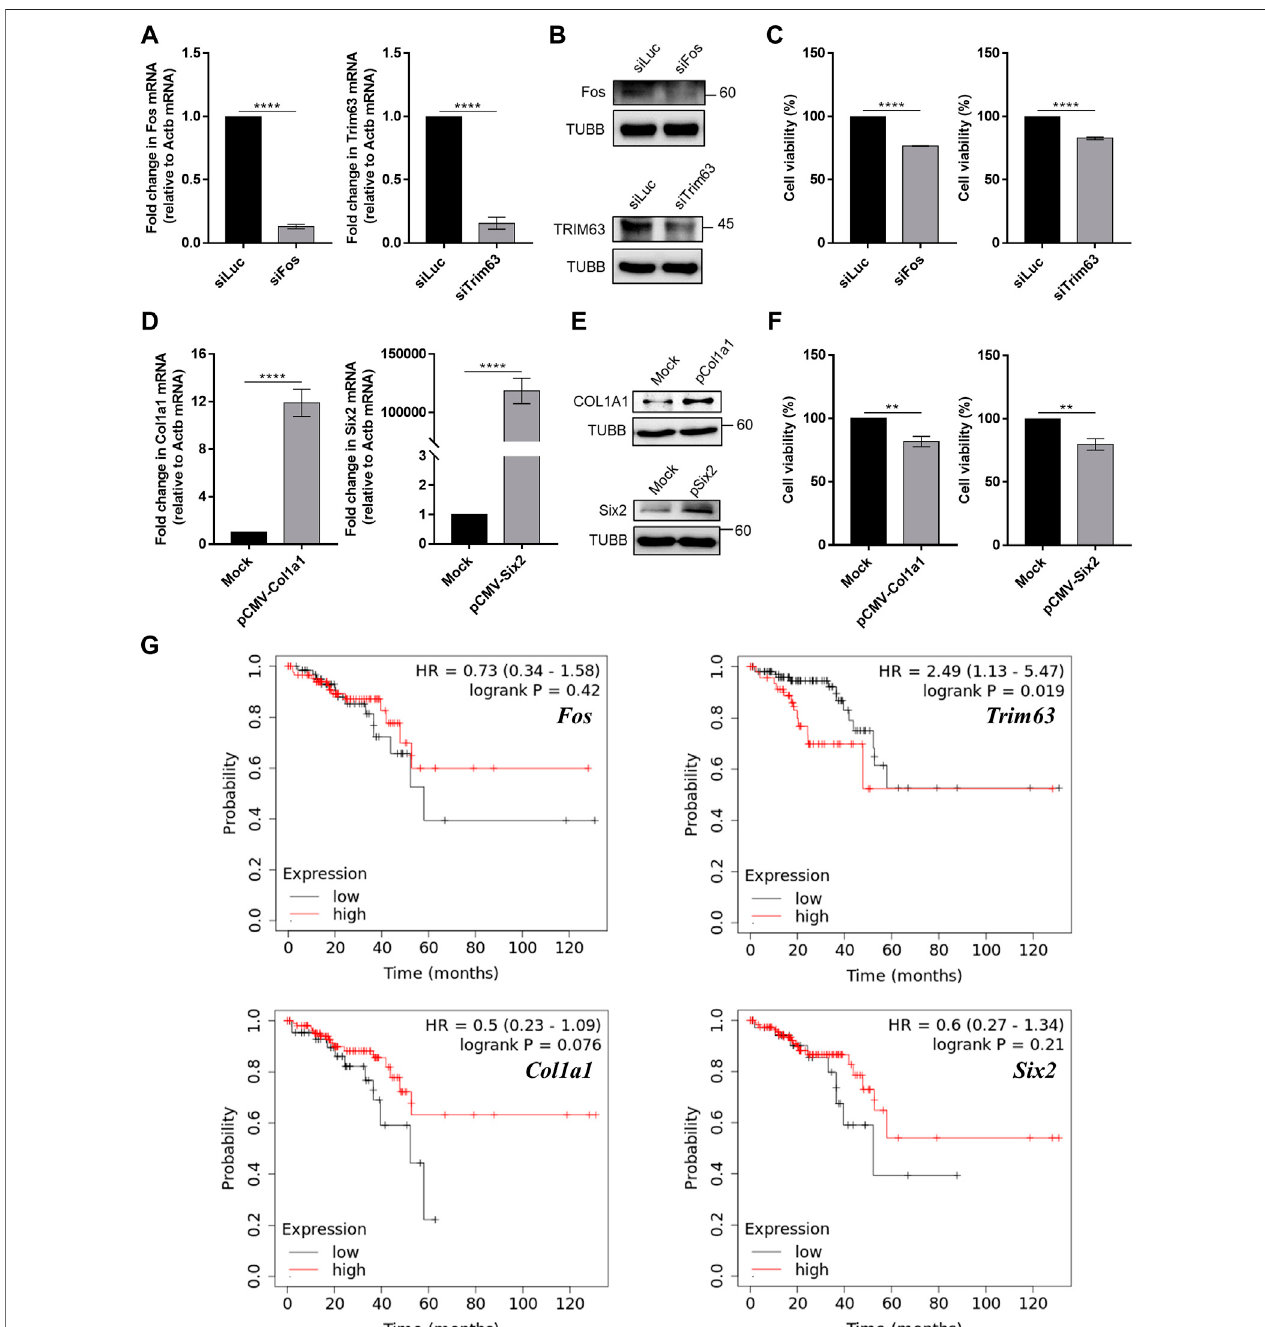
FIGURE6| Modulationofskeletalmusclegeneexpression affectscancercellviability invitro . (A) Knockdownef fi ciencyofsiRNAsagainst Fos and Trim63 inCT26 cells was con fi rmed using RT-qPCR. (B) The protein expression of Fos and Trim63 in siRNA-transfected cells. (C) Cell viability of CT26 cells with knockdown of skeletal muscle genes. (D) Overexpression of Col1a1 and Six2 resulted in increased mRNA expression, as con fi rmed using RT-qPCR. (E) Increased mRNA expression resulted in increased protein levels. (F) Viability ofCT26 cells when Col1a1 or Six2 wasoverexpressed. Theoverexpression of Col1a1 resultedin anabout 20%reductionin CT26 cellviability. (G) PlotsofKaplan – Meierestimatesfortheoverallsurvivalrateofrectumadenocarcinomapatientsbasedontheexpression ofskeletalmusclegenes. Withtheexceptionof Fos, ouranticancercandidategenesshowedanexpectedassociationwiththeoverallsurvivalrate.ForRT-qPCRandcellviabilitydata,theaverage of three biological replicates is shown, with error bars indicating the standard error of the mean. For statistical analysis, the student ’ s t-test was performed against the control (siLuc or Mock), and the statistical signi fi cance was indicated with a number of *. ** p -value < 0.01, *** p -value < 0.001, **** p -value < 0.0001.